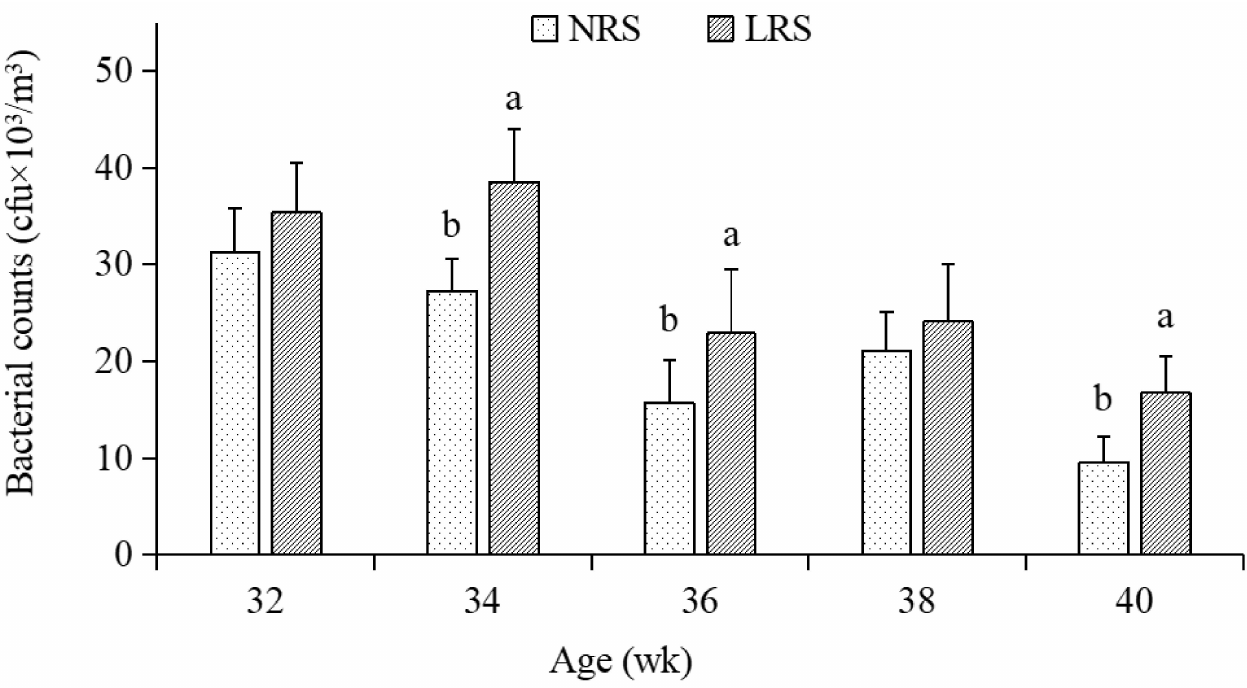
Figure 2. The bacterial counts of indoor aerosols in the two housing system houses. NRS, plastic-net housing system; LRS, floor-litter housing system; a,b . Means with different superscripts within each period are significantly different ( p < 0.05). Lines connected above the bars indicate the standard deviation. wk,